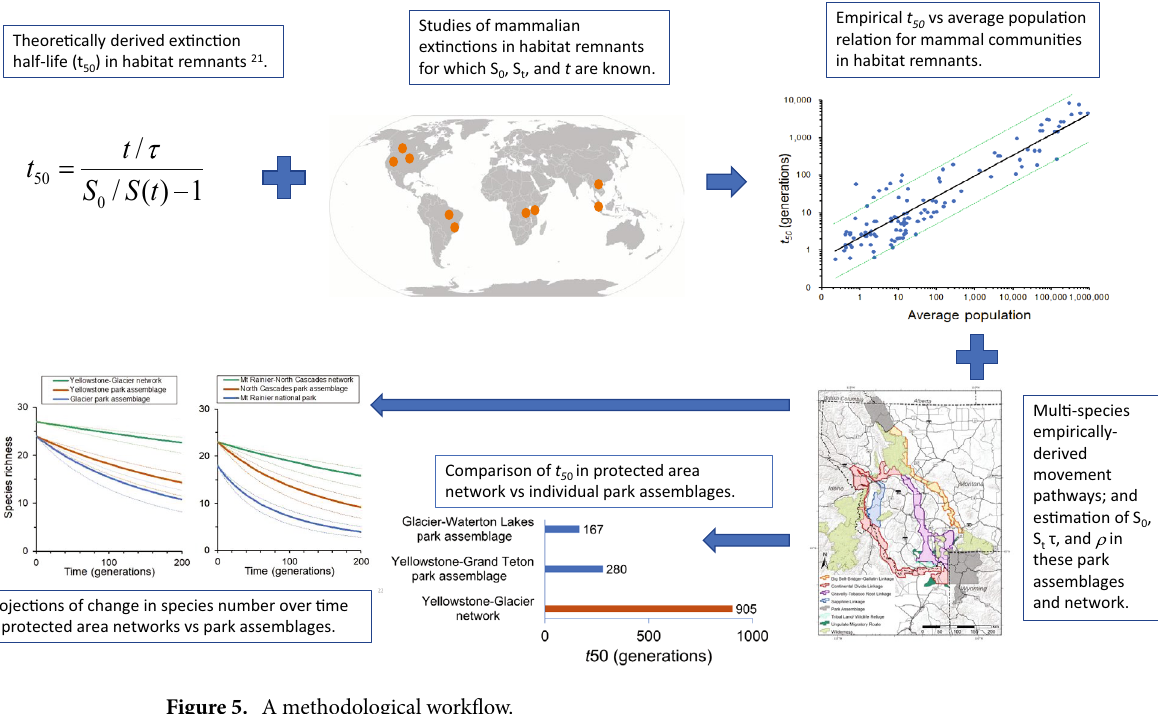
Figure 5. A methodological